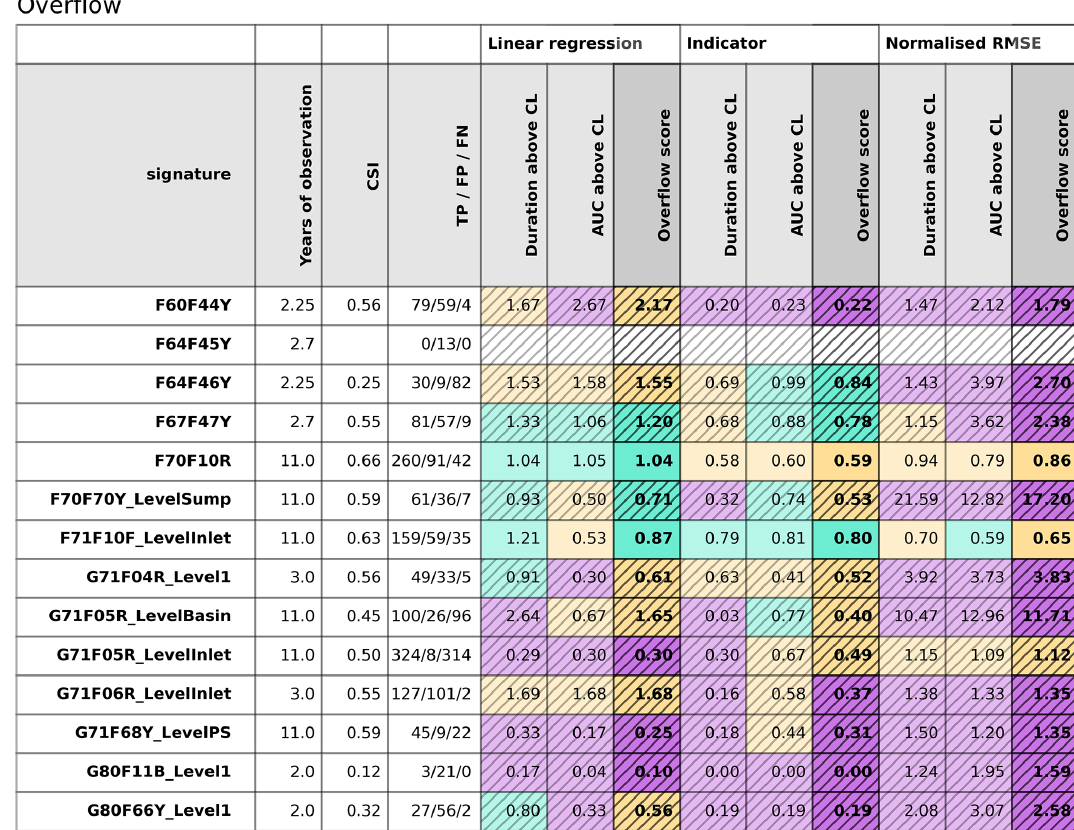
Table 4. Results from the categorical and the three statistical analysis methods for the objective overflow. Colour-coding as described in Fig. 1 and Table